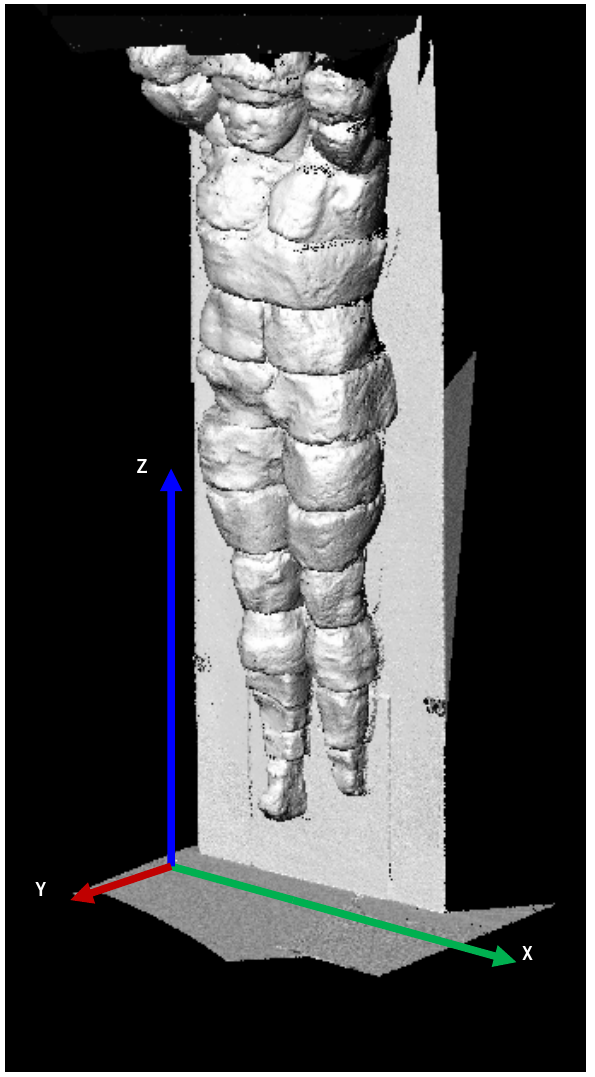
Figure 10. Laser scanner point cloud The 3D model was closed with vertical plane for the back and was used as reference for comparison with the photogrammetric data and as 3D model for structural analysis.